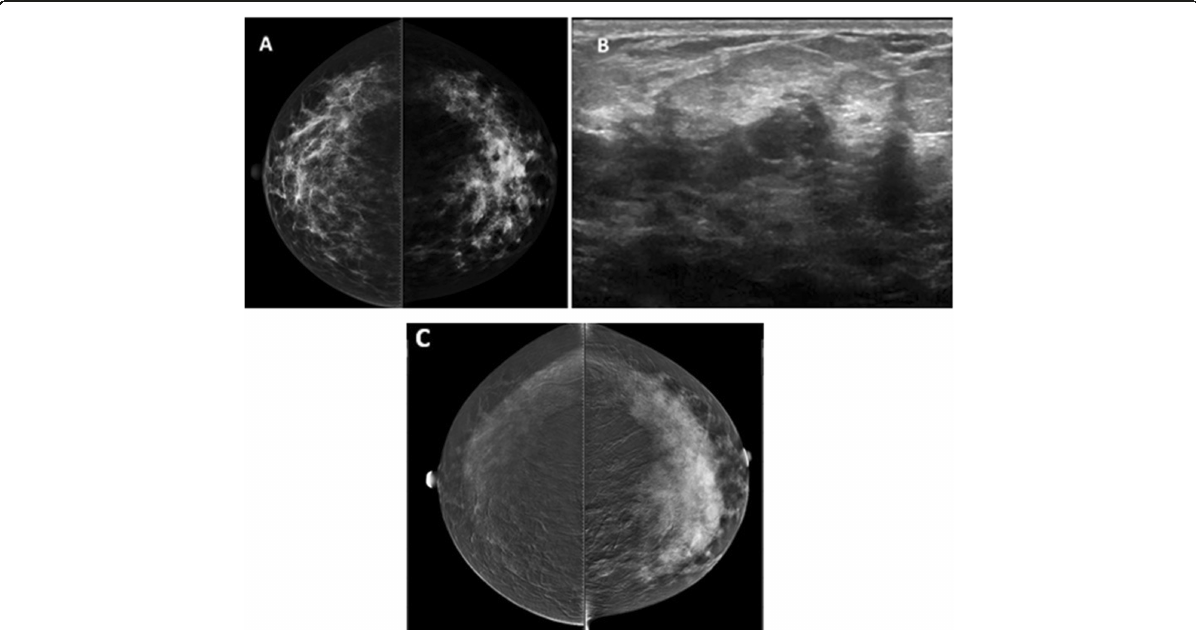
Fig. 2 Global asymmetry of the left breast ( a ). Ultrasound showed subtle diffusely altered parenchyma (indeterminate ultrasound correlate) ( b ). CESM showed diffuse heterogeneous malignant non-mass enhancement ( c ). Biopsy revealed invasive lobular